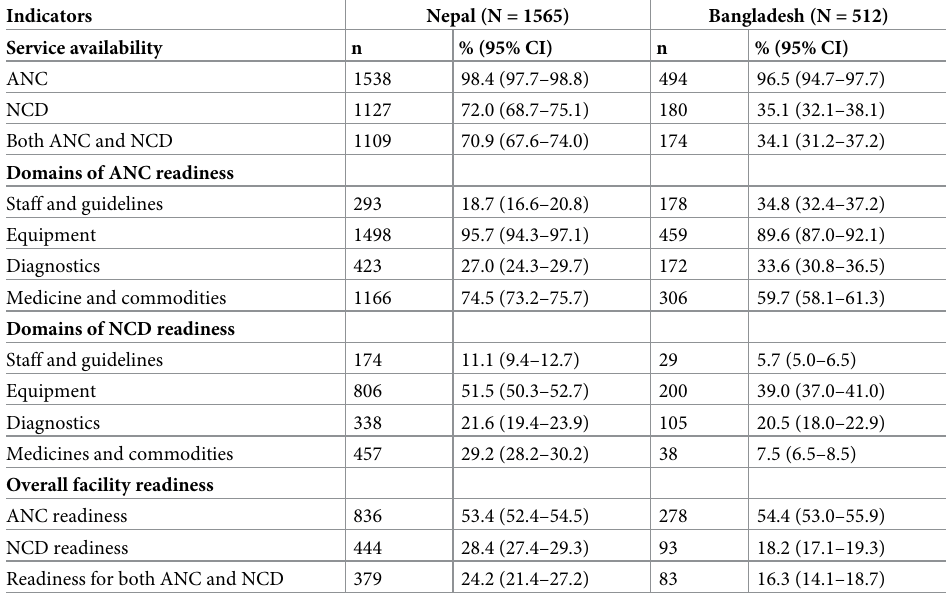
Table 4. Service availability and readiness to provide ANC and NCD